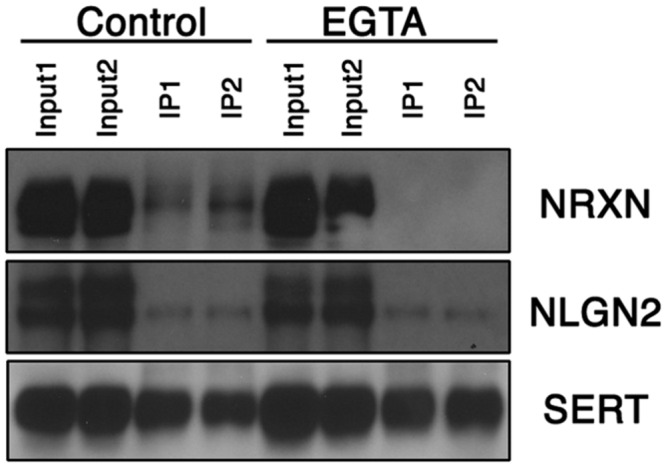
Midbrain NLGN2:SERT interaction is Ca2+-independent. Co-immunoprecipitation assays using SERT antibody were performed with (EGTA lanes) or without (control lanes) the presence of Ca2+ chelator EGTA (10 mM). SERT-bound neurexin was largely removed under Ca2+ free conditions, whereas NLGN2 remained bound to SERT, suggesting neurexin is associated with SERT through NLGN2. Input lanes represent 1% of total protein lysates, co-IP lanes represent 40% of total eluents. Blot is a representative of three independent experiments.